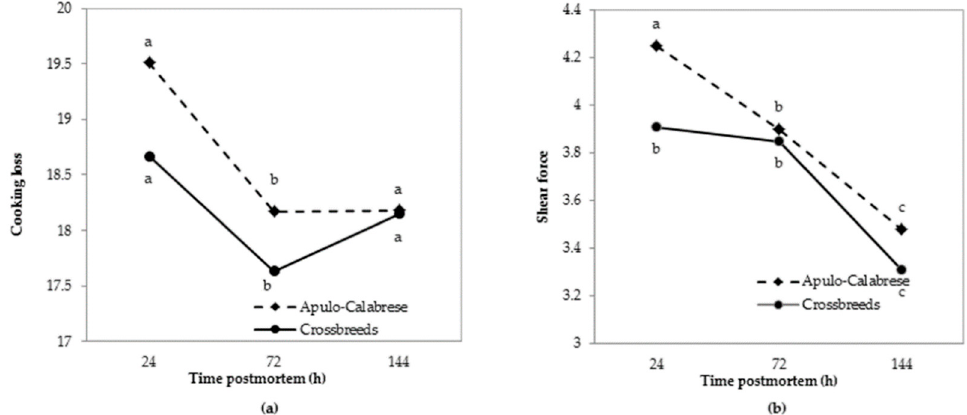
Figure 3. Changes in cooking loss ( a ) and shear force ( b ) in the longissimus thoracis in Apulo-Calabrese and crossbreed pigs over time. Different letters in the graphs (a, b, c) indicate significant effects ( p < 0.05).